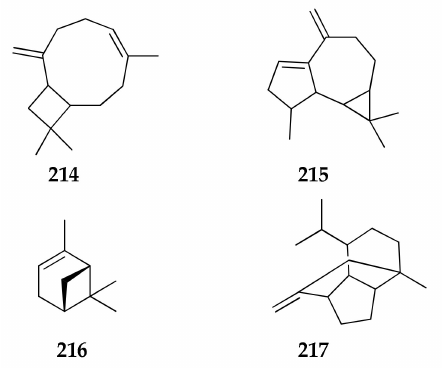
Figure 30. Structures of volatile terpenes.